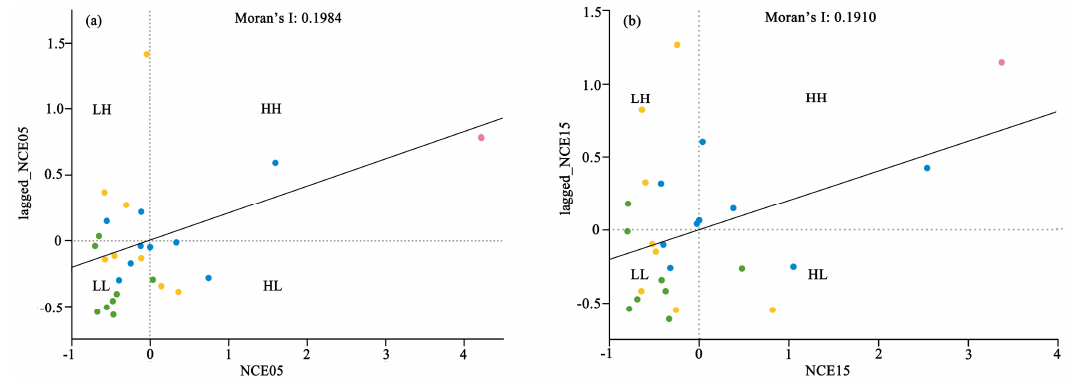
Figure 8. Moran scatter plots of net carbon emissions for the YRDUA in 2005 ( a ) and 2015 ( b ). Green, blue, yellow, and rose represent the cities of Anhui, Jiangsu, and Zhejiang provinces, and Shanghai, respectively. H—high;